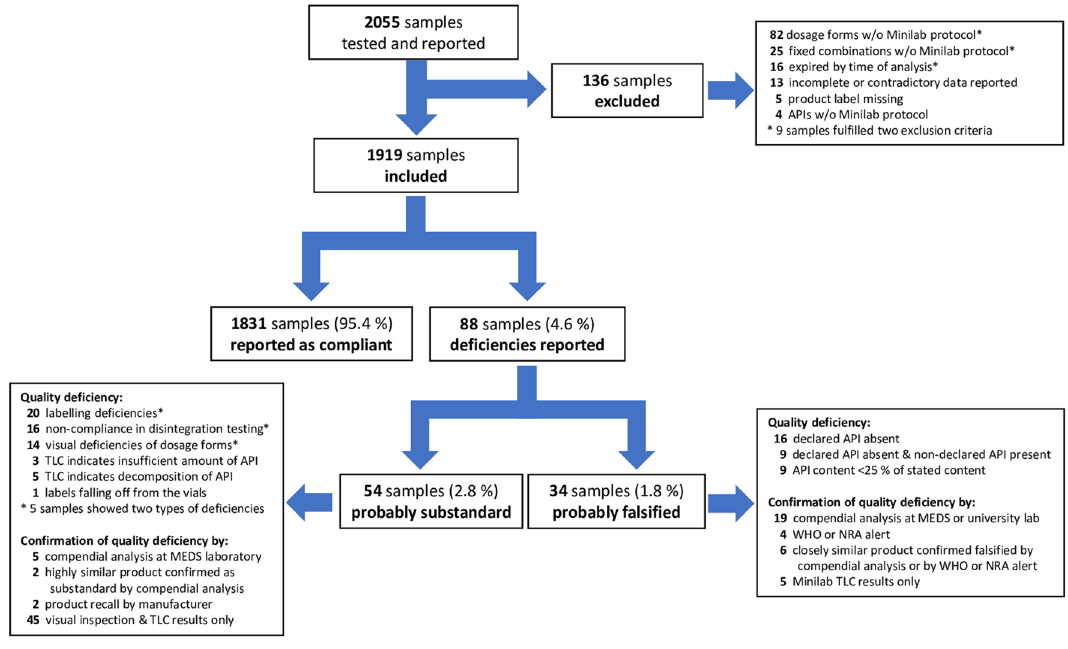
Figure 1. Flow chart showing the evaluation of the reported medicine quality